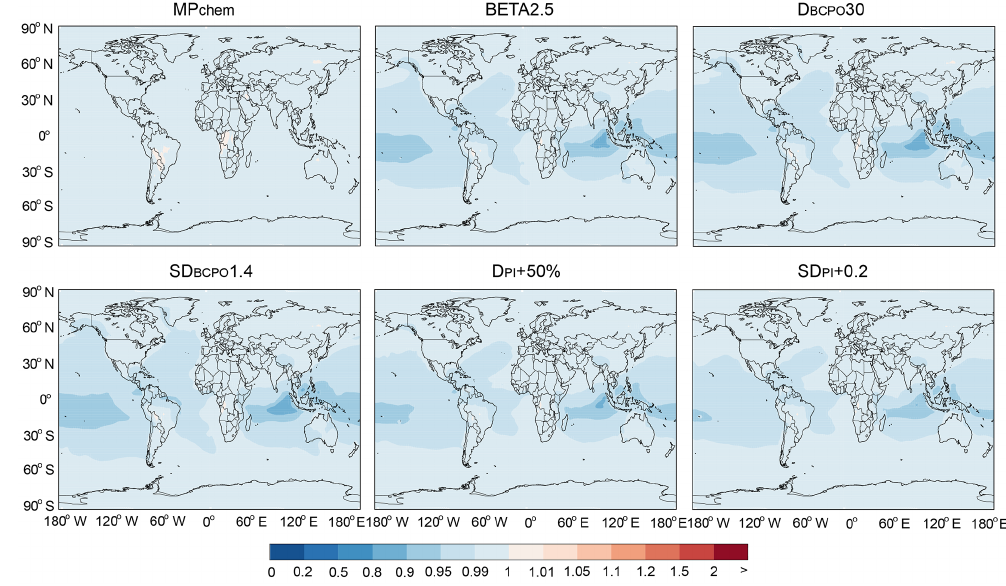
Figure 13. Same as Fig. 11 but for BC column burden.